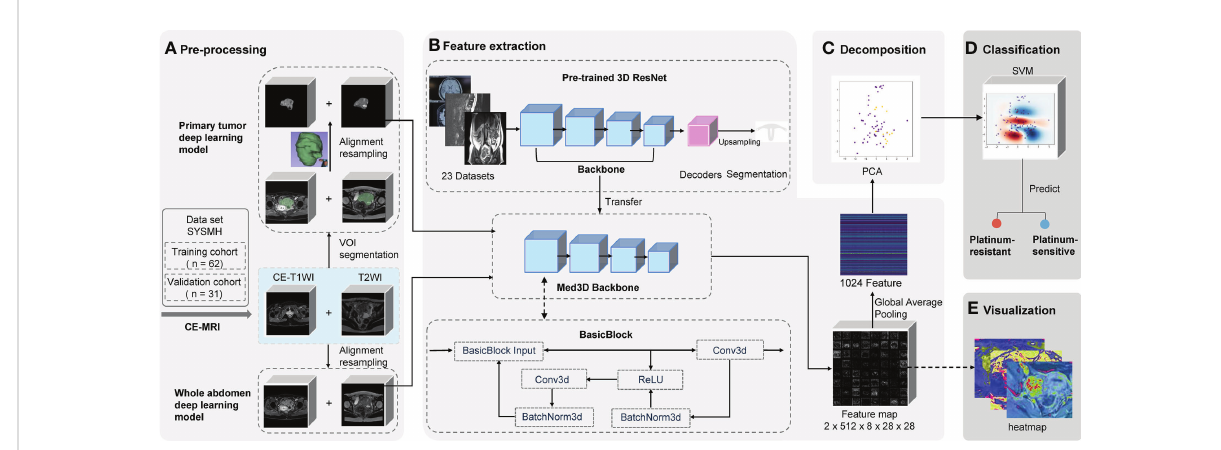
FIGURE 2 Schematic of two deep learning frameworks. The primary tumor model uses the primary tumor in CE-T1WI and T2WI sequences as the VOI with manual segmentation by radiologists. Contrastingly, the whole abdomen model uses the entire abdomen volume as VOI without any segmentation or delineation by hand. VOI on CE-T1WI and T2WI sequences were prepared for (A) pre-processing, which consisted of image segmentation (or not), registration, and normalization; (B) the backbone of the pre-trained 3D ResNet network was transferred to extract features and a global average pooling layer was added so that 1,024 features could be extracted from each patient; (C) the PCA was used for decomposition; (D) the platinum sensitivity prediction model was constructed using SVM; (E) the feature map that the last convolutional layer output was generated as heat maps for visualization. CE-T1WI, contrast-enhanced T1-weighted imaging; T2WI, T2-weighted imaging; VOI, volume of interest; MRI, magnetic resonance imaging; PCA, principal component analysis; SVM, support vector